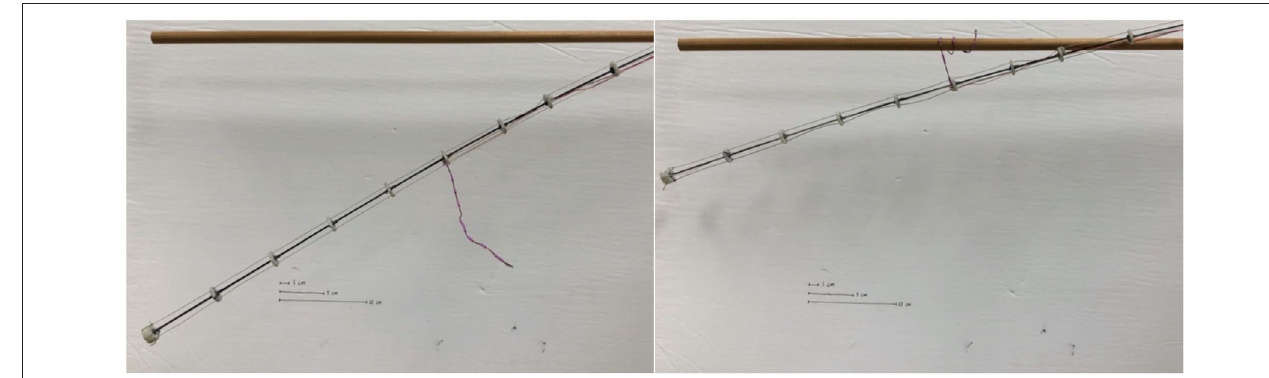
FIGURE 10 | Robot tendril grasping environment with a stabilizing searcher.